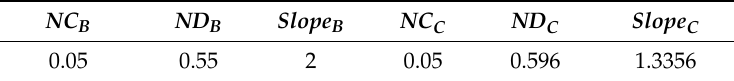
Table 4. Optimization of response surface